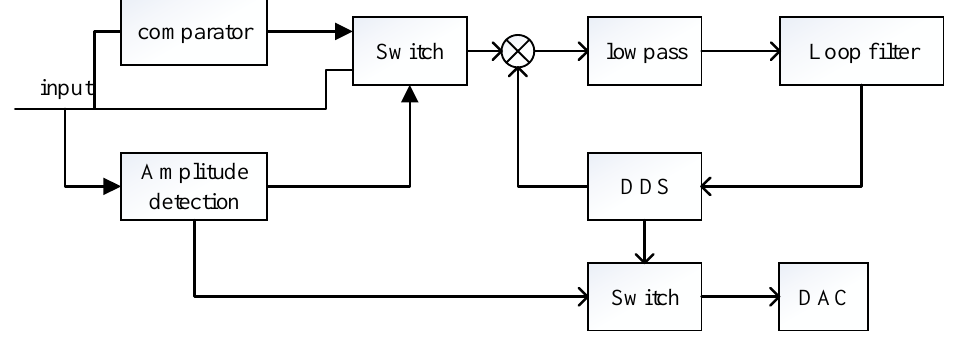
Figure 11. Control system of quick start driving loop.